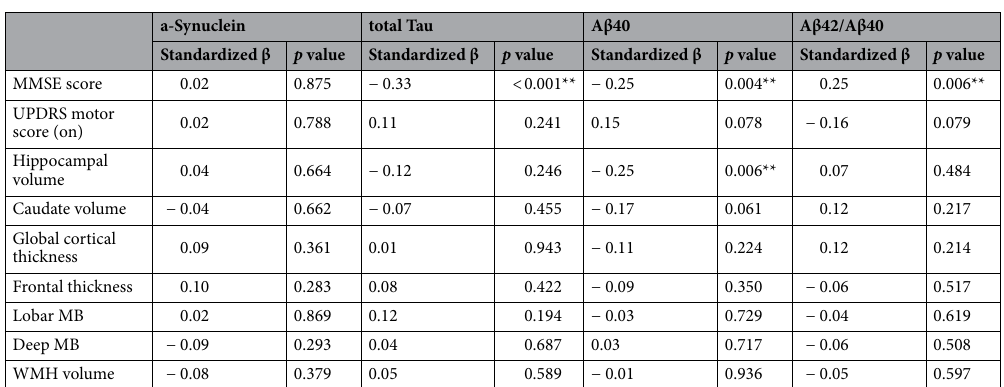
Table 4. The associations between plasma biomarkers and clinical or neuroimaging characteristics. Analysis was adjusted for age and sex. MB microbleed, MMSE mini-mental state examination, UPDRS Unified Parkinson’s Disease Rating Scale, WMH white matter